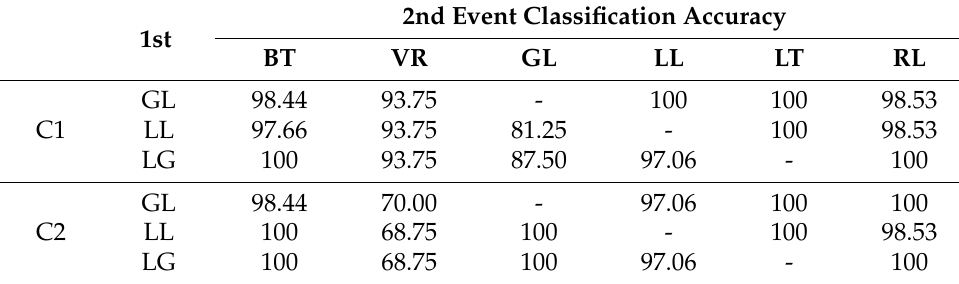
Table 2. Summary of performance of successive event